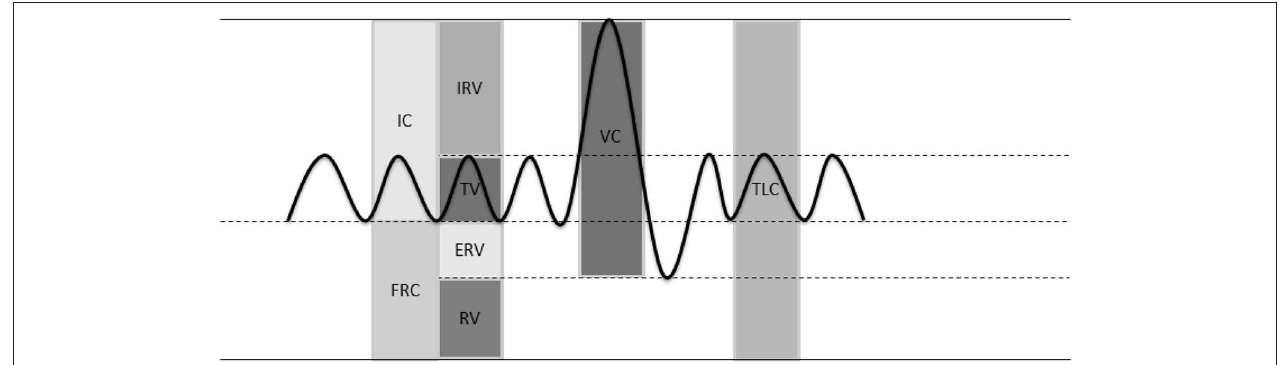
FIGURE 1 | Lung volumes. Inspiratory capacity (IC), functional residual capacity (FRC), inspiratory reserve volume (IRV), tidal volume (TV), expiratory reserve volume (ERV), residual volume (RV), vital capacity (VC), total lung capacity